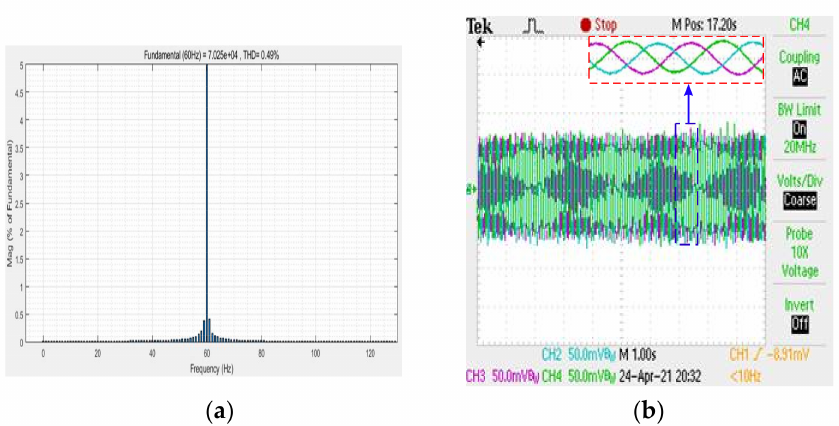
Figure 10. ( a ) Experimental waveforms of three-phase current and DC bus voltage at PCC under L g = 0.28 mH (SCR = 4); ( b ) THD of PCC current under L g = 0.28 mH (SCR = 4).